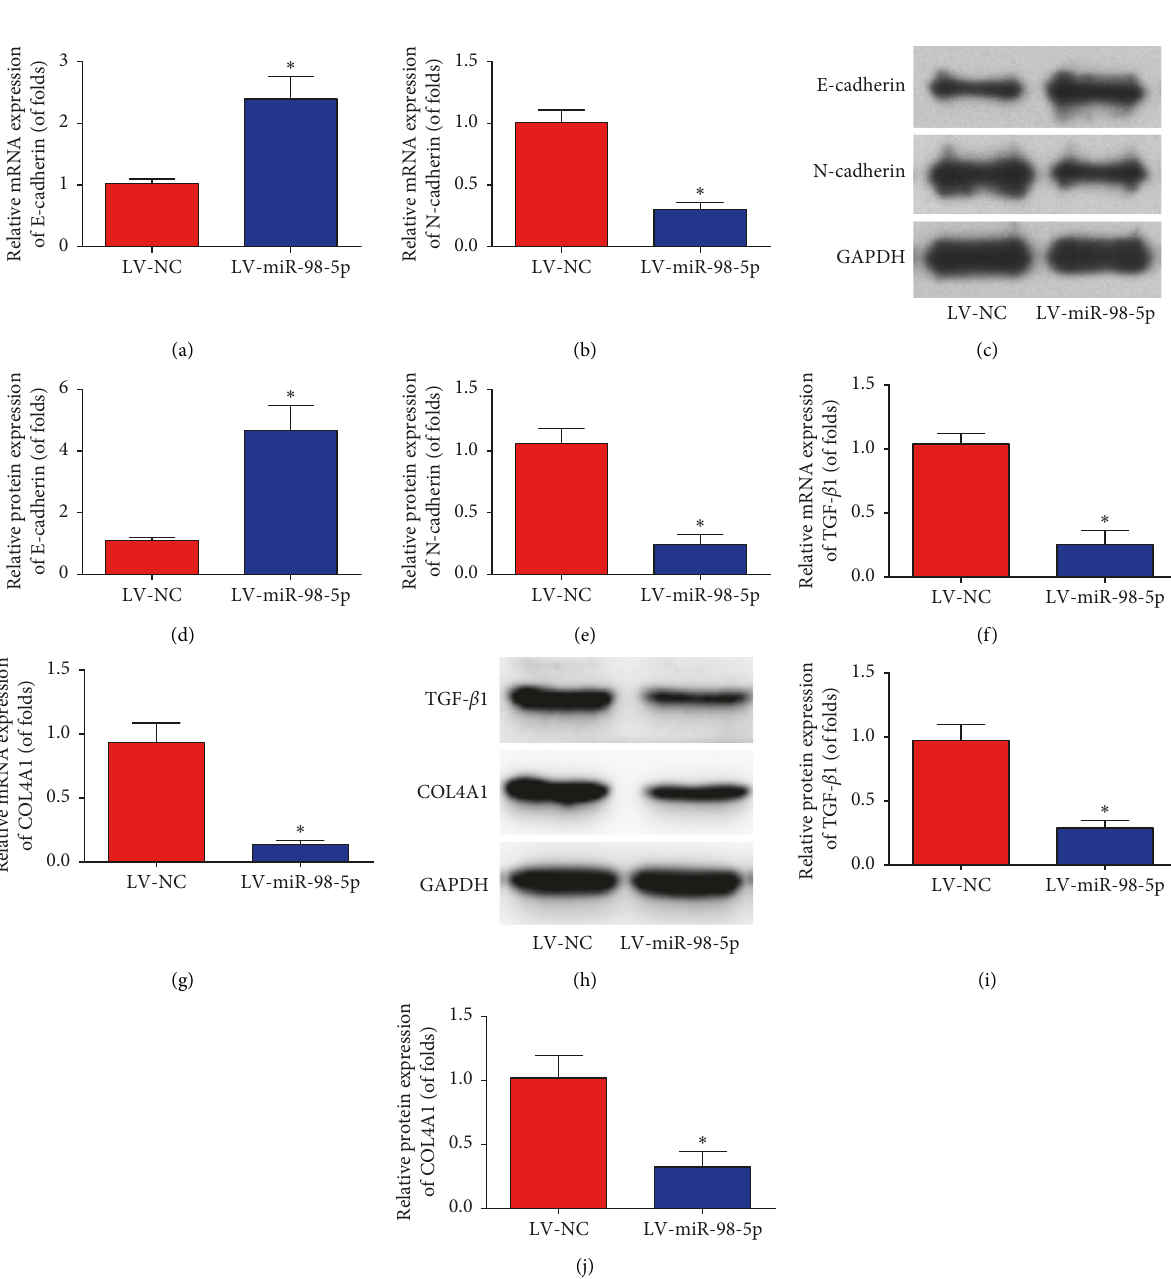
Figure 4: EMT and renal fibrosis were restrained by overexpression of miR-98-5p in db/db mice. mRNA expression of E-cadherin (a) and N-cadherin (b). Western blot images of E-cadherin and N-cadherin (c). Quantification of the western blot images of E-cadherin and N-cadherin (d and e). mRNA expression of TGF- β 1 (f) and COL4A1 (g). The western blot images of TGF- β 1 and COL4A1 (h). Quantification of the western blot images of TGF- β 1 (i) and COL4A1 (j). n 8 for each group. Data are representative of three (cid:31) P experiments. Error bars stand for the mean SD of at least triplicate experiments. 0 . ∗ ± <